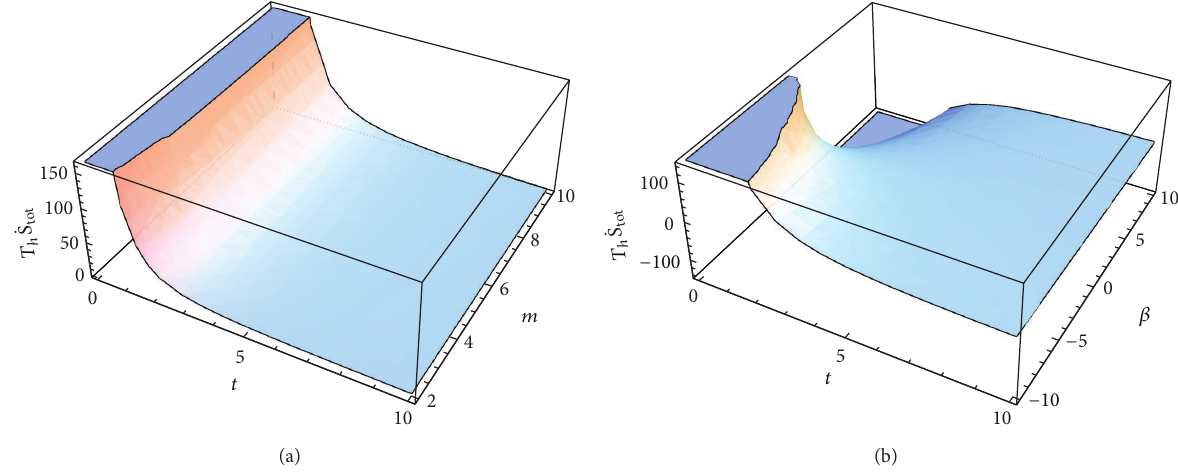
Figure 2: Evolution of GSLT for 𝑓(𝑅,𝐿 𝑚 ) = 𝛼𝑅 + 𝛽𝑅 2 + 𝛾𝐿 𝑚 , plot (a) shows the bound on parameter 𝑚 for 𝛽 = −5 , whereas in plot (b) we set 𝑚 = 10 to find bounds on 𝛽 . We choose 𝛼 = 𝛾 = 2